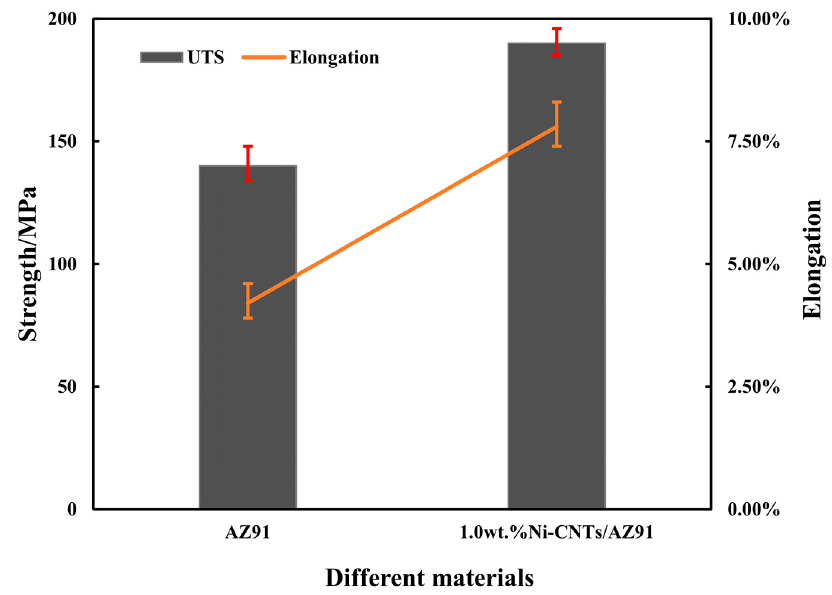
Figure 9. Tensile mechanical properties of the two materials (AZ91 matrix material, 1.0 wt.% Ni- CNTs/AZ91 magnesium matrix composite) at room temperature.